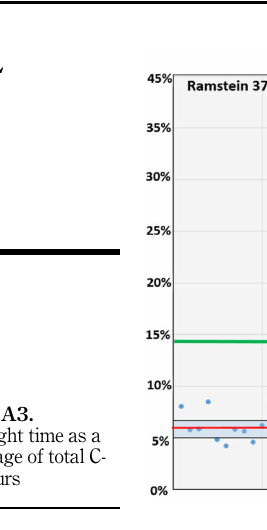
Category 7: Training flight time – flying time that is categorized as nonoperational As before, Table A8 displays the basic statistical data derived from the 90 co-pilots, while